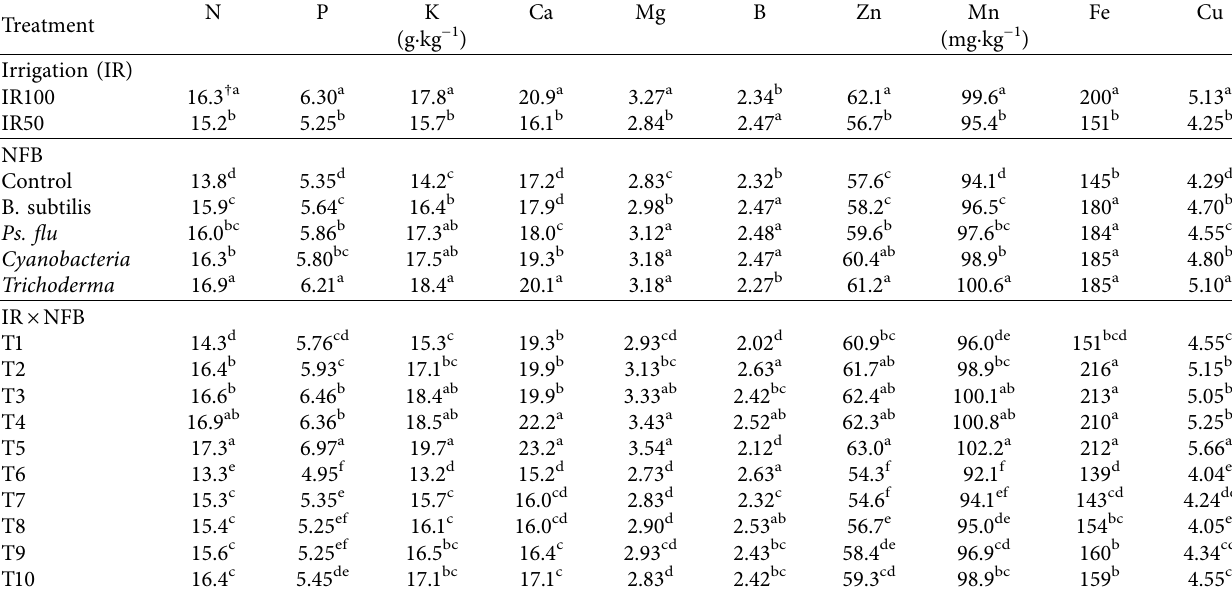
Table 2: Effects of nitrogen-fixing bacteria (NFB) on concentrations of macronutrients (N, P, K, Ca, and Mg) and micro-nutrients (B, Zn, Mn, and Fe, Cu) of clary ( Salvia sclarea ) plants grown under two irrigation (IR) treatments.